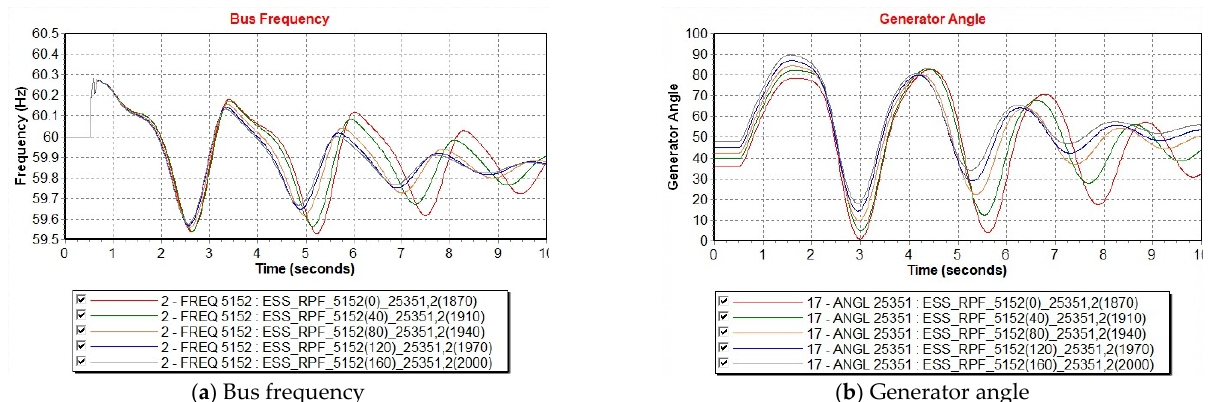
Figure 12. Relief effect of generation curtailment using BESS. Table 1. Performance of a hybrid control BESS to relieve generation curtailment